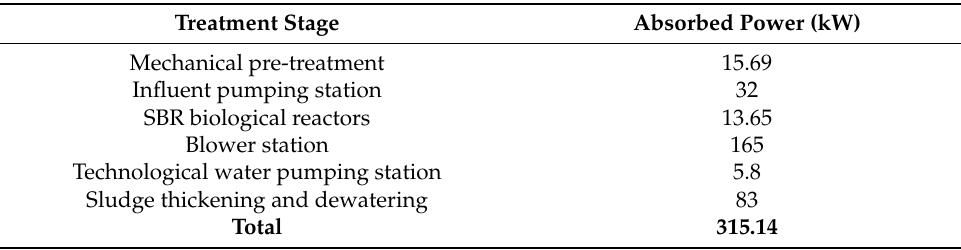
Table 1. Main consumers of the WWTP and their absorbed power.